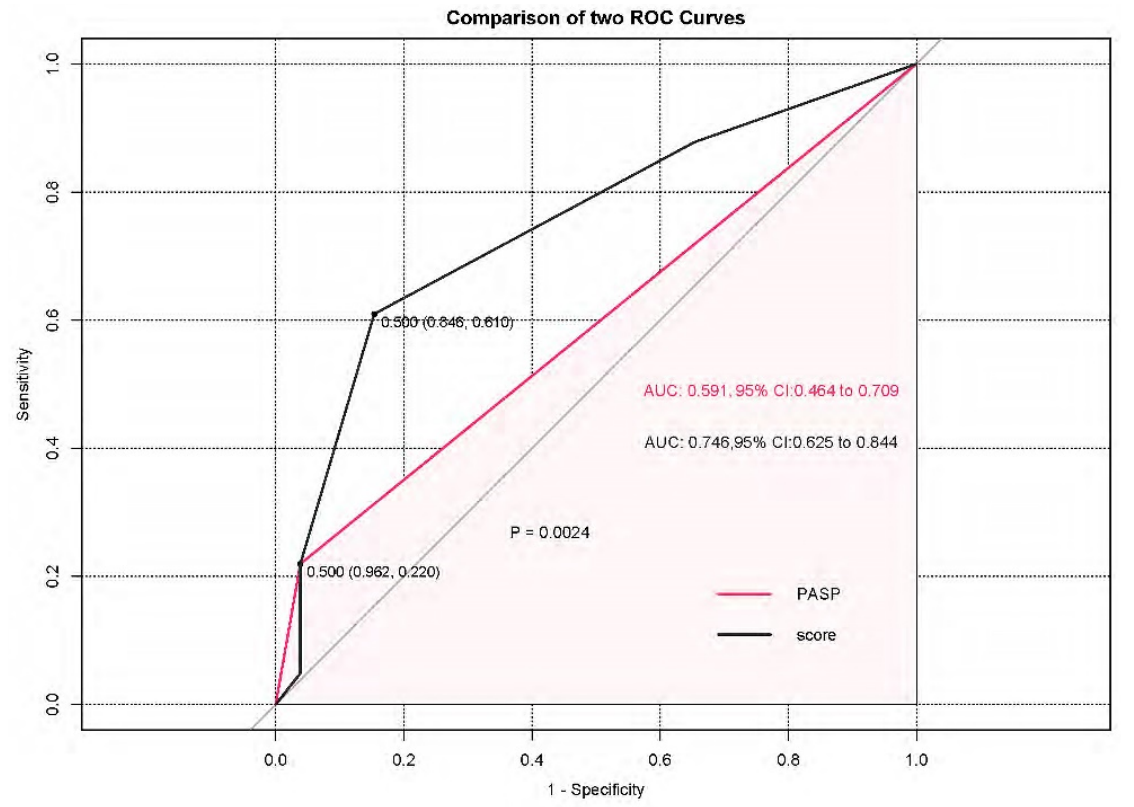
Figure 4. Comparisons of ROC curves of PASP alone and the composite scores in predicting all-cause mortality in patients with severe CLD-PH. AUC: area under the curve; PASP: pulmonary arterial systolic pressure; CLD: chronic lung diseases; PH: pulmonary hypertension; ROC: receiver operating characteristic.